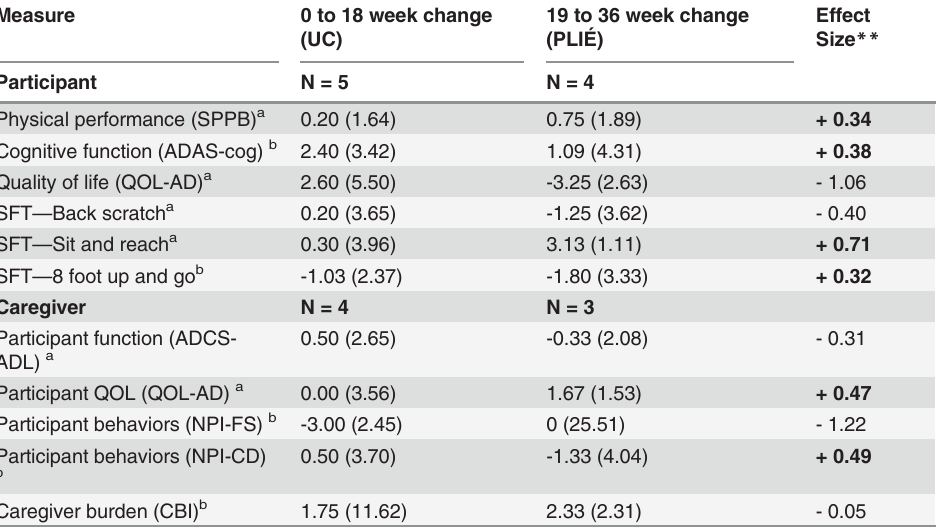
Table 6. Within-Group Changes * and Effect Sizes in Participant and Caregiver Measures, Group